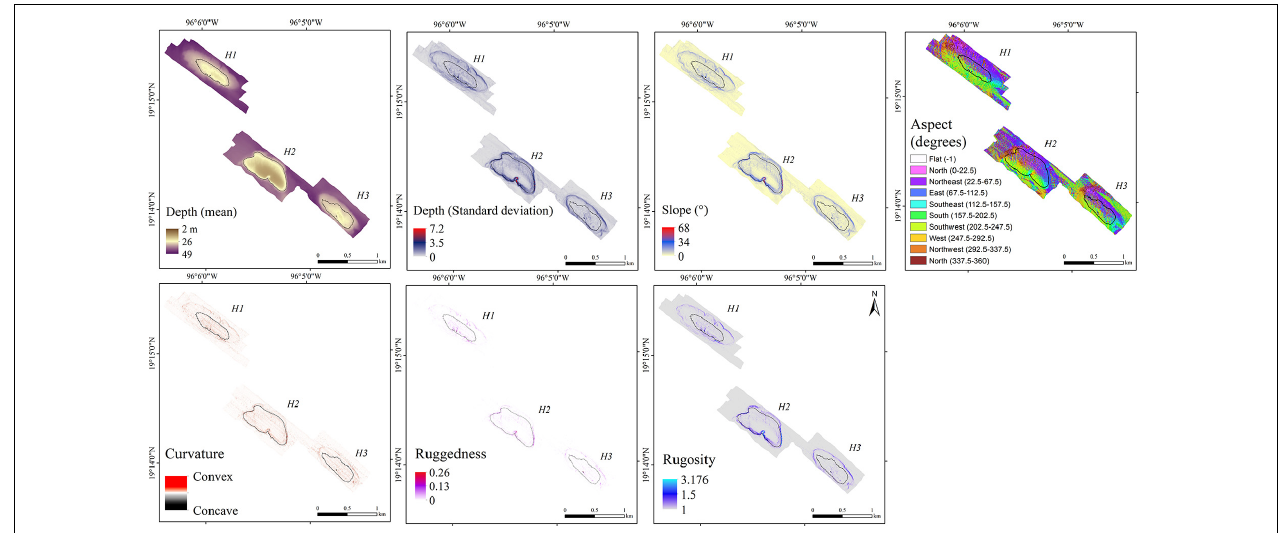
FIGURE 4 | Digital terrain models showing the result of the topographic variability analysis: mean depth, depth standard deviation, slope, aspect, curvature, ruggedness and rugosity for the H1, H2 and H3; 30 m isobath shown in black.